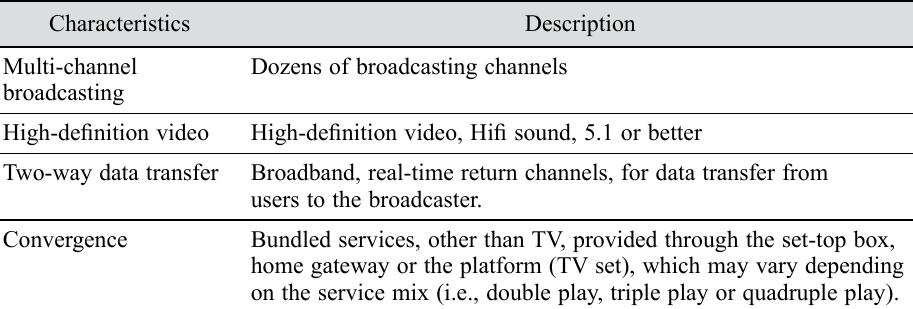
Table 1. Consumer-perceived performance characteristics of